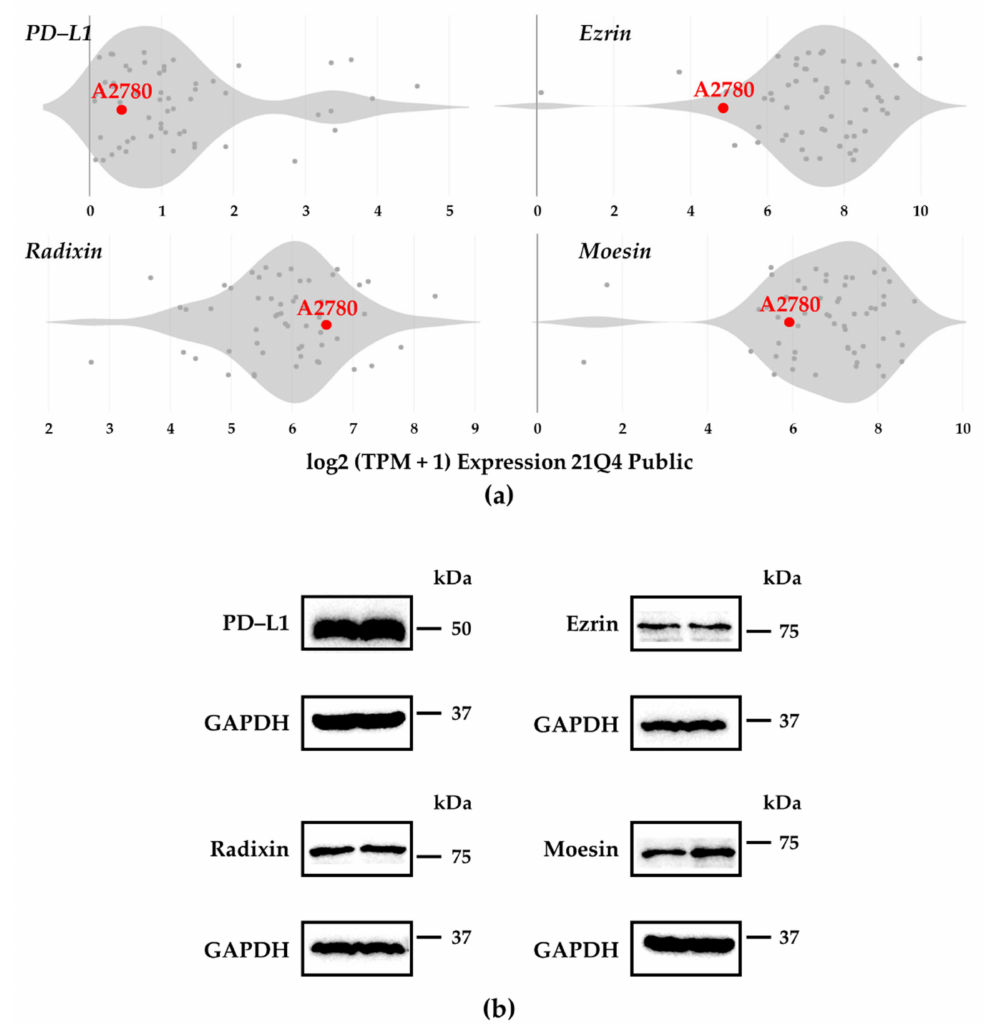
Figure 1. Gene and protein expression patterns of programmed death ligand–1, ezrin, radixin, and moesin in A2780 cells. ( a ) Violin plots showing the median gene expression (log2 (TPM + 1)) of programmed death ligand–1 (PD–L1), ezrin, radixin, and moesin (ERM) in numerous human ovar- ian adenocarcinoma strains obtained from the database of the Cancer Dependency Map (DepMap) portal data explorer, Broad (2021): DepMap 21Q4 Public. ( b ) Representative western blotting